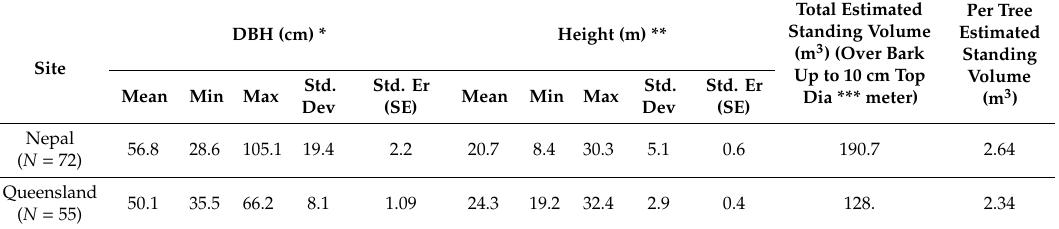
Table 2. Measured growth variables and standing volume of study